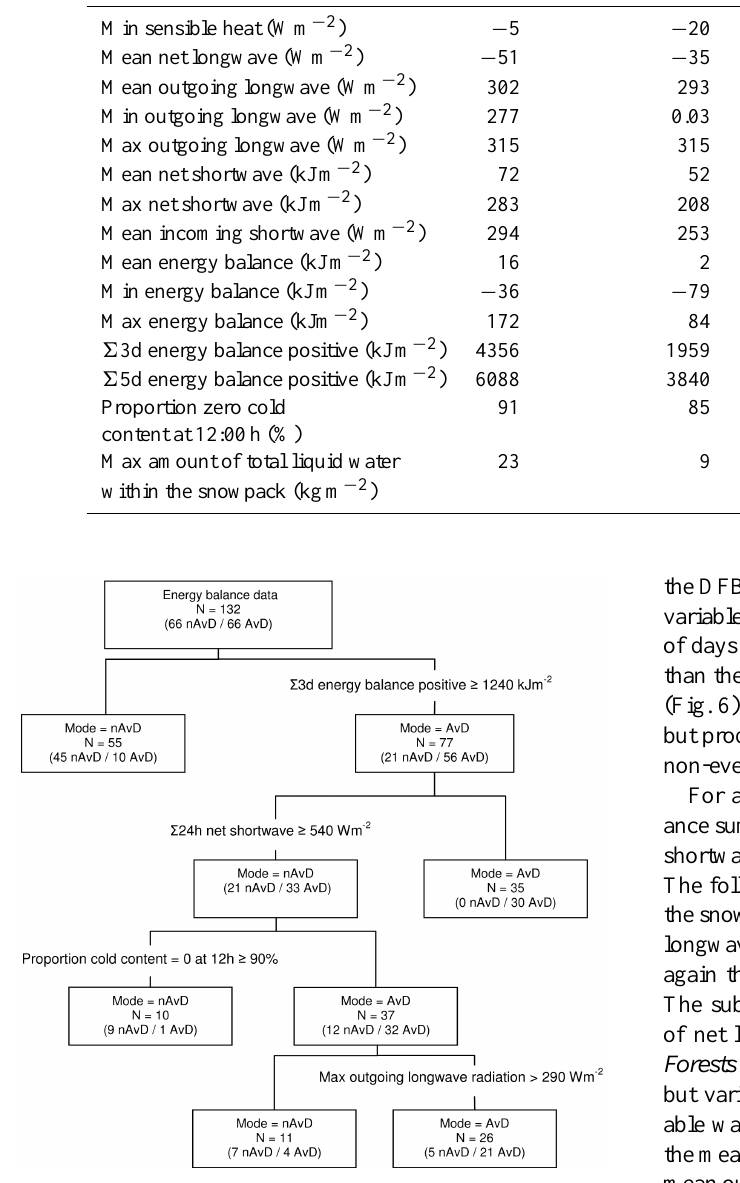
Fig. 4. Classification tree to discriminate between avalanche (AAI > 2) and non-avalanche days. Input data were all energy balance variables calculated for a 35 ◦ south-facing slope at 2500ma.s.l. Forecast scores of the tree: probability of detection (POD) = 0.84; probability of non-events (PON) = 0.83; true skill score (HK) =